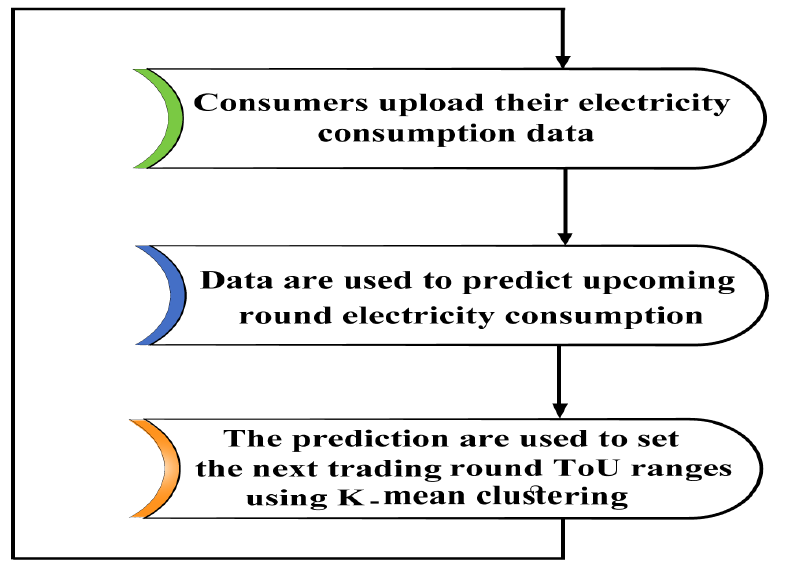
Figure 2. The proposed model defining TOU peak and off-peak ranges.